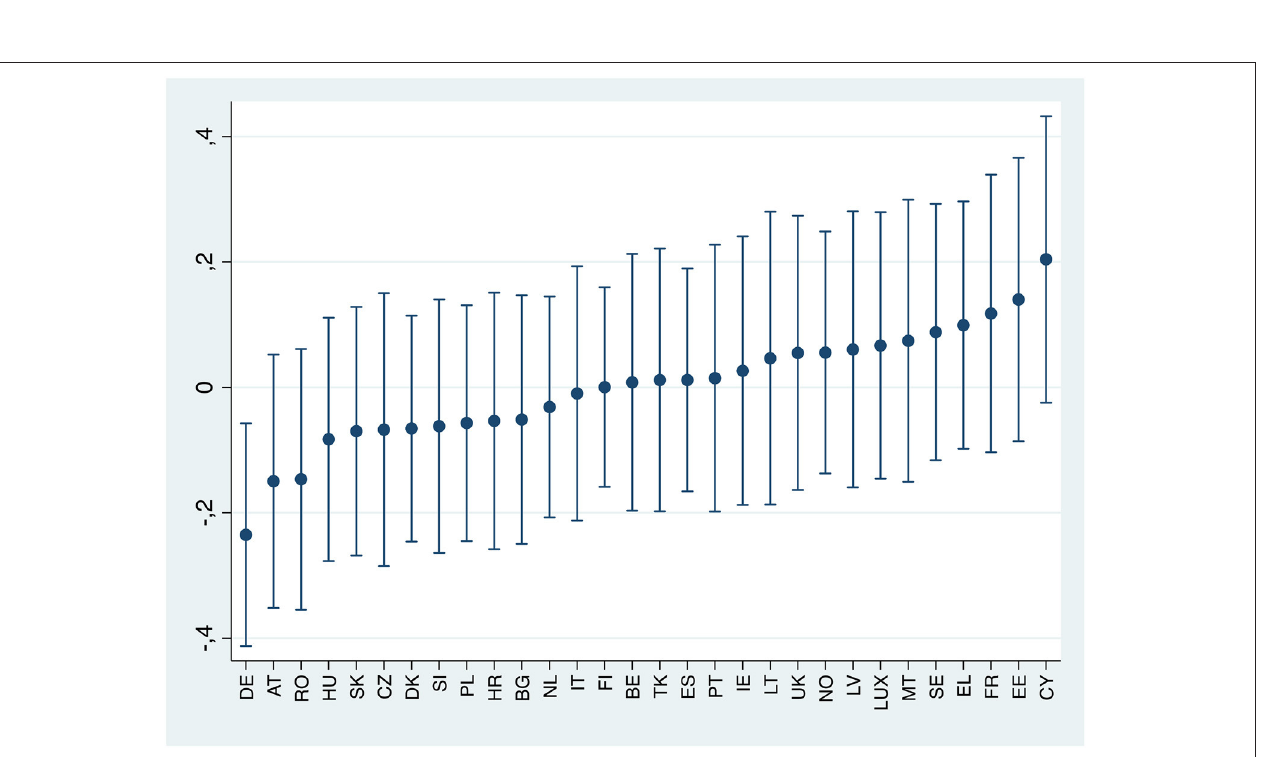
Frontiers in Sociology |